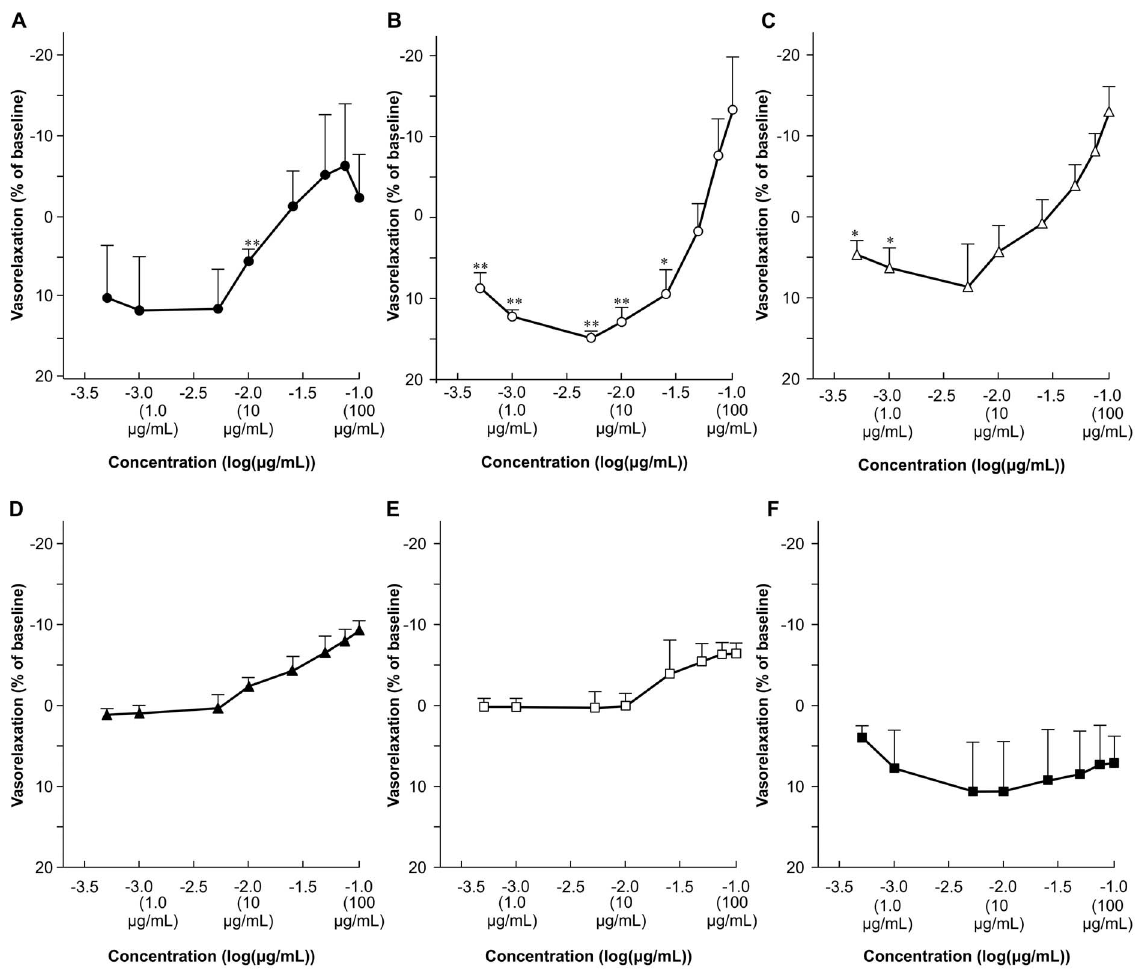
Figure 1. FBP concentration-vasorelaxation curves of phenylephrine-preconstricted thoracic aorta rings from SHRs. Dose dependent response to cumulatively increasing concentration of DVWY (A), FDART (B), VVG (C), FQ (D), VAE (E), and WTFR (F). Vasorelaxant rate is expressed as the percentage reduction of evoked contraction. Each data point and bar represent the mean 6 S.E. (n=3). * p , 0.05, ** p , 0.01, versus pre-treatment tension, Student’s t -test.